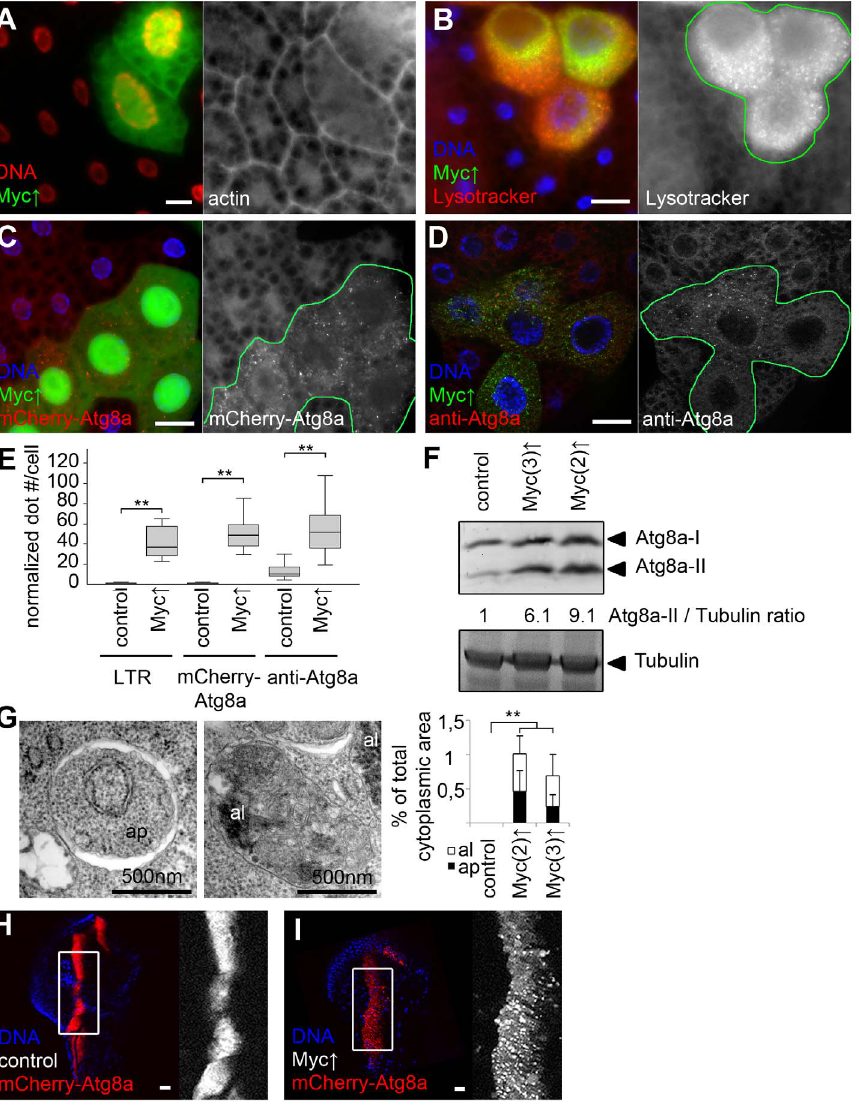
Figure 2. Myc overexpression induces autophagy in Drosophila. (A) Myc overexpression in GFP-marked fat body cell clones leads to cell- autonomous overgrowth. (B–D) Enhanced punctate Lysotracker staining (B), mCherry-Atg8a dot formation (C) and endogenous Atg8a labeling (D) is observed in Myc-overexpressing fat body cell clones (marked by expression of LAMP1-GFP in panels B and D and by GFP in panel C), when compared to surrounding control tissue in well-fed larvae. (E) Quantification of data presented in B–D, n=7 for all genotypes. (F) Fat body-specific expression of Myc from transgenes located on chromosome 2 or 3 increase the amount of activated Atg8a-II compared to control fat bodies of well-fed larvae. Numbers indicate the level of lipidated Atg8a-II relative to the loading control Tubulin in different genotypes, as determined by densitometric evaluation. (G) Fat body-specific overexpression of Myc induces formation of typical double-membrane autophagosomes (ap) and autolysosomes that contain cytoplasmic material in various stages of degradation (al), n=5 for all genotypes. (H, I) Myc overexpression leads to punctate mCherry- Atg8a labeling (I) and increased expression area in the patched domain of wing discs compared to control discs (H). Scalebars in A–D and H–I equal 20 m m. Statistically significant differences are indicated, ** p ,